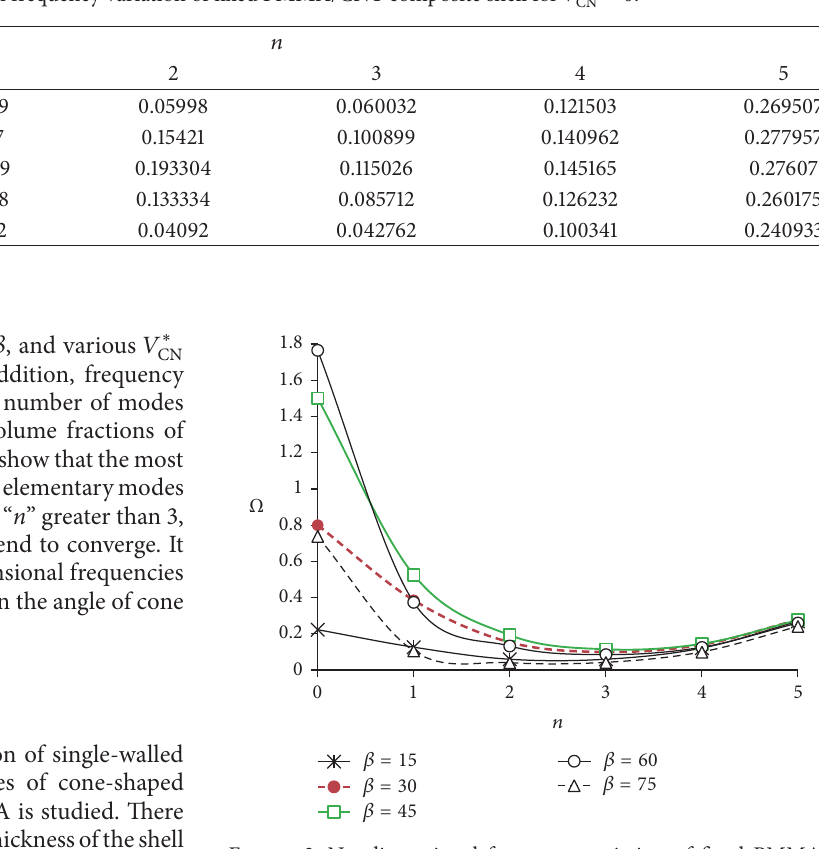
Table 4: Nondimensional frequency variation of fixed PMMA/CNT composite shell for 𝑉 ∗ CN = 0 .